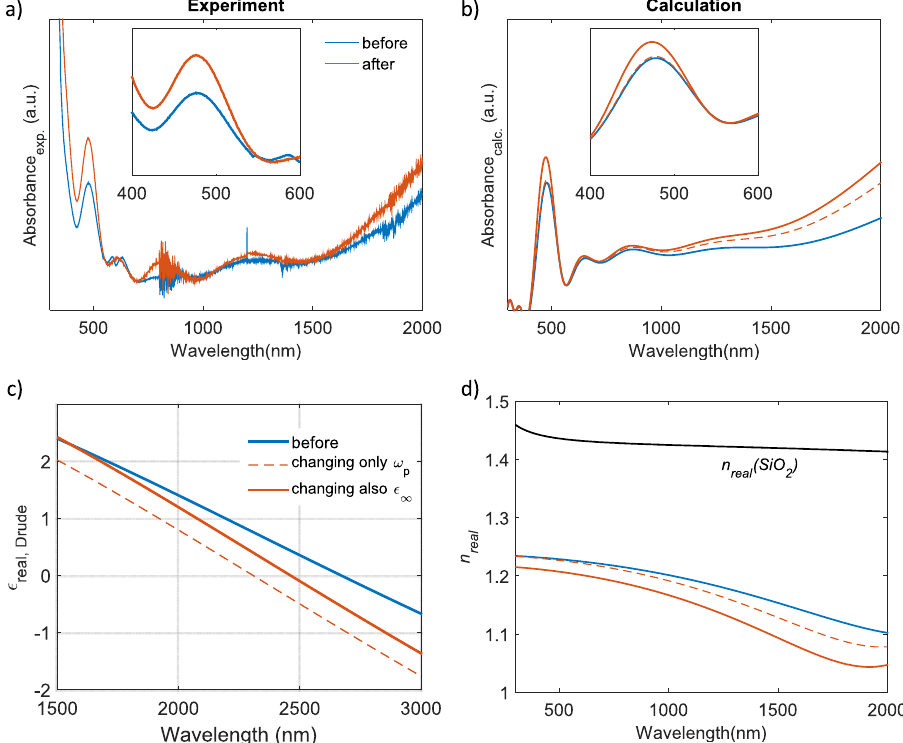
Figure 2. ( a ) Experimental absorption spectrum of the SiO 2 /ITO photonic crystal, before and after UV exposure (photodoping); ( b ) calculation of the absorption spectrum with the transfer matrix method, integrated with the Drude model and the Maxwell-Garnet effective medium approximation; ( c ) real part of the Drude dielectric function of the ITO nanoparticles; ( d ) real part of the refractive index of the ITO nanocomposite film as employed in the calculation. Black curve: SiO 2 , blue to red curves: ITO